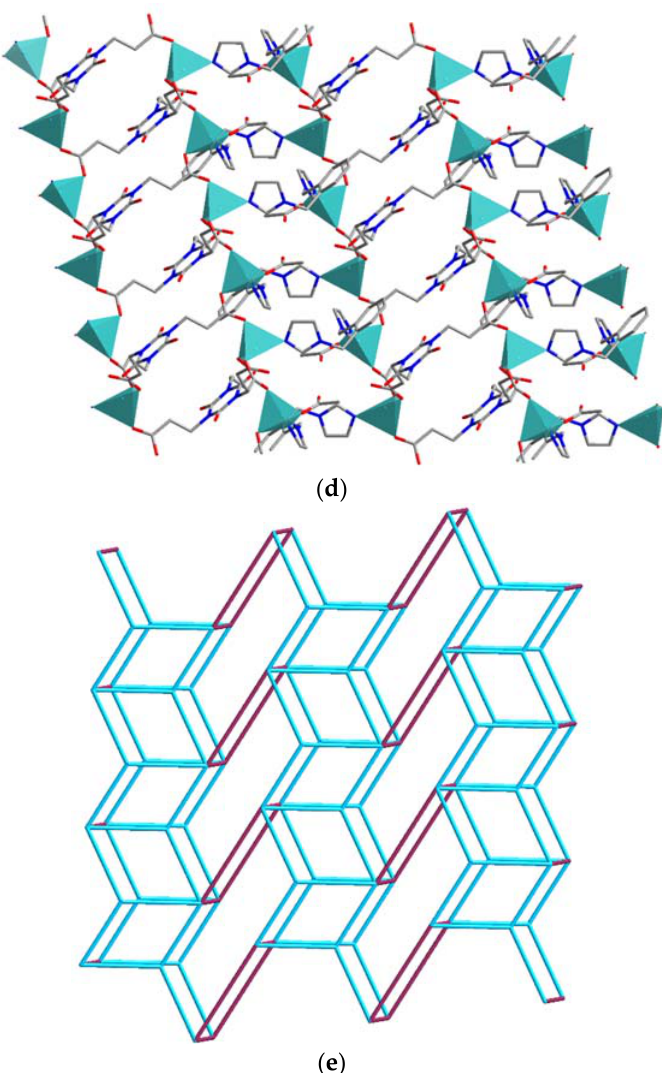
Figure 3. ( a ) The coordination environment of the Zn II ion in complex 3 ; ( b ) The coordination mode of the H 3 L ligand; ( c ) The 2D [Zn(H 3 L)] n sheet along the c direction; ( d ) The 3D framework of the complex 3 along the b direction; ( e ) The {4 2 ∙ 6} ∙ {4 4 ∙ 6 10 ∙ 8} ‐ 3 , 6T24 topology of the complex 3 (cyan, Zn; blue, N; red, O; gray, C; pink,